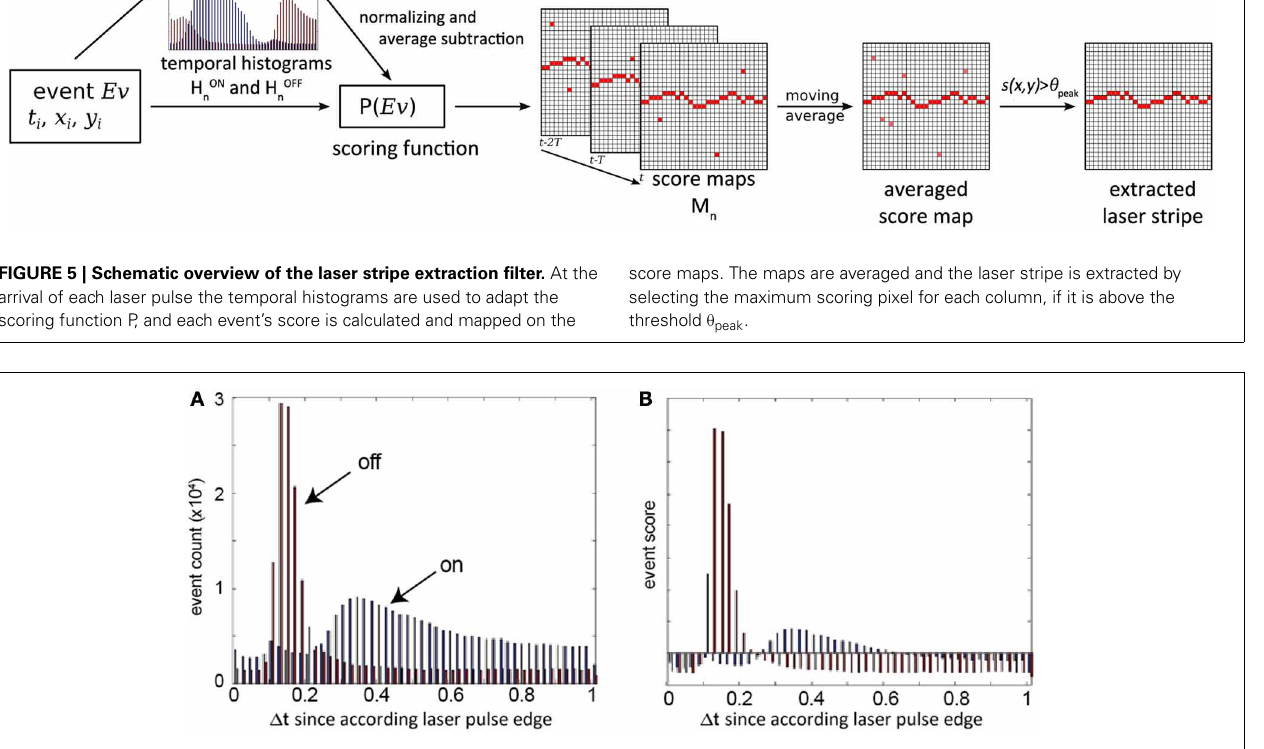
FIGURE 6 | Scoringfunction:examplesofeventhistogramsofthelaserpulsedat1kHzatthereliefusedforthereconstruction.(A) Measuredhistograms of ON and OFF events following laser pulse ON and OFF edges. (B) Resulting OFF and ON scoring functions after normalization and mean subtraction.